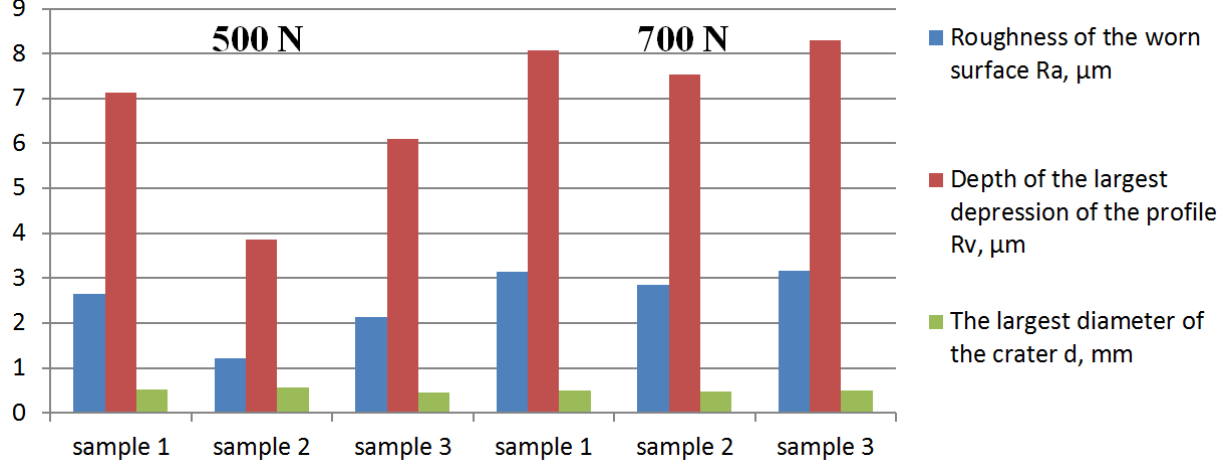
Figure 15. Values of roughness and crater sizes on samples of modified low-chromium cast iron after cyclic impact tests.